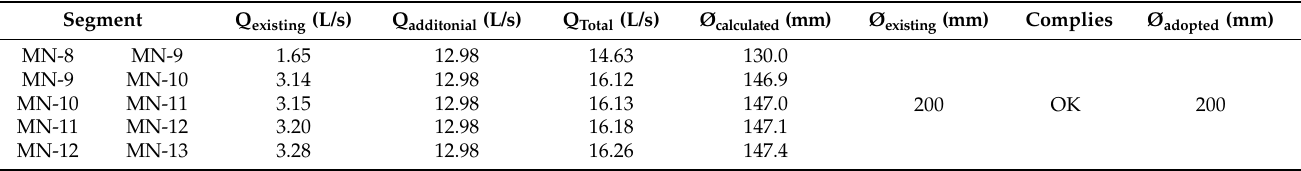
Table 9. Capacity of the pipeline connecting to the sewerage network of EA1.